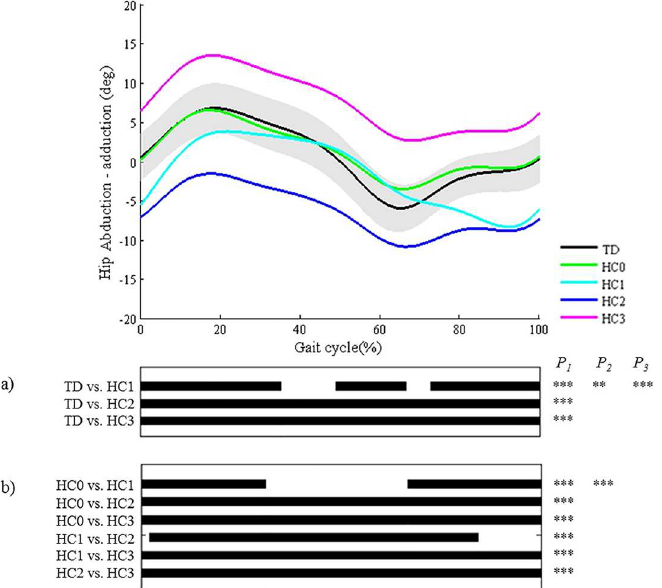
Fig 13. Hip in the coronal plane (HC). Top graph shows the mean kinematic angleof TD gait and of each consensus-based pattern of the hip in the coronal plane. Black bars indicatesignificantgait phases during which the SPM{t} statistic exceededthe critical threshold. Panel ( a ) shows results of hypothesis2 (i.e. unpairedt-tests, α = 0.01); panel ( b ) shows results of hypothesis3 (i.e. post-hoc unpairedt-tests, α = 0.002). * p < 0.01, ** p < 0.001, *** p < 0.00001.P 1 indicatesthe p-value of the first cluster duringthe gait cycle, P 2 the second cluster, etc.